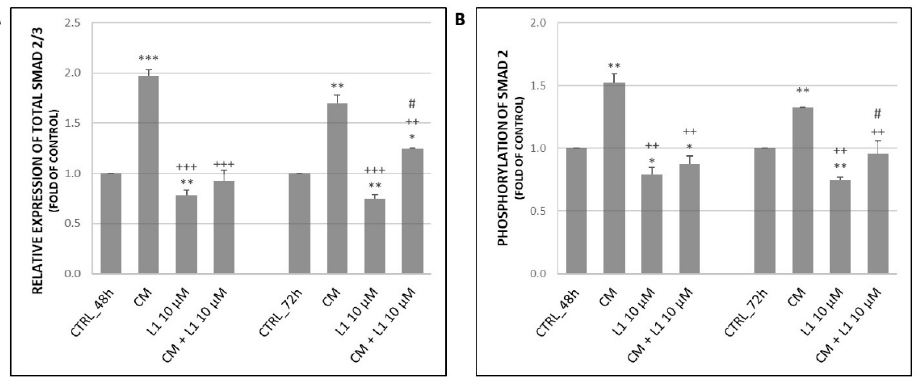
Figure 8. Changes in expression ( A ) and phosphorylation ( B ) of Smad proteins after 48 h and 72 h of CM from BJ-5ta cells and L1 treatment. Representative data obtained by three independent experiments using flow cytometry. CM—conditioned medium. Significantly different * p < 0.05, ** p < 0.01, *** p < 0.001 vs. untreated cells (control); ++ p < 0.01, +++ p < 0.001 vs. CM; # p < 0.05 vs. L1.